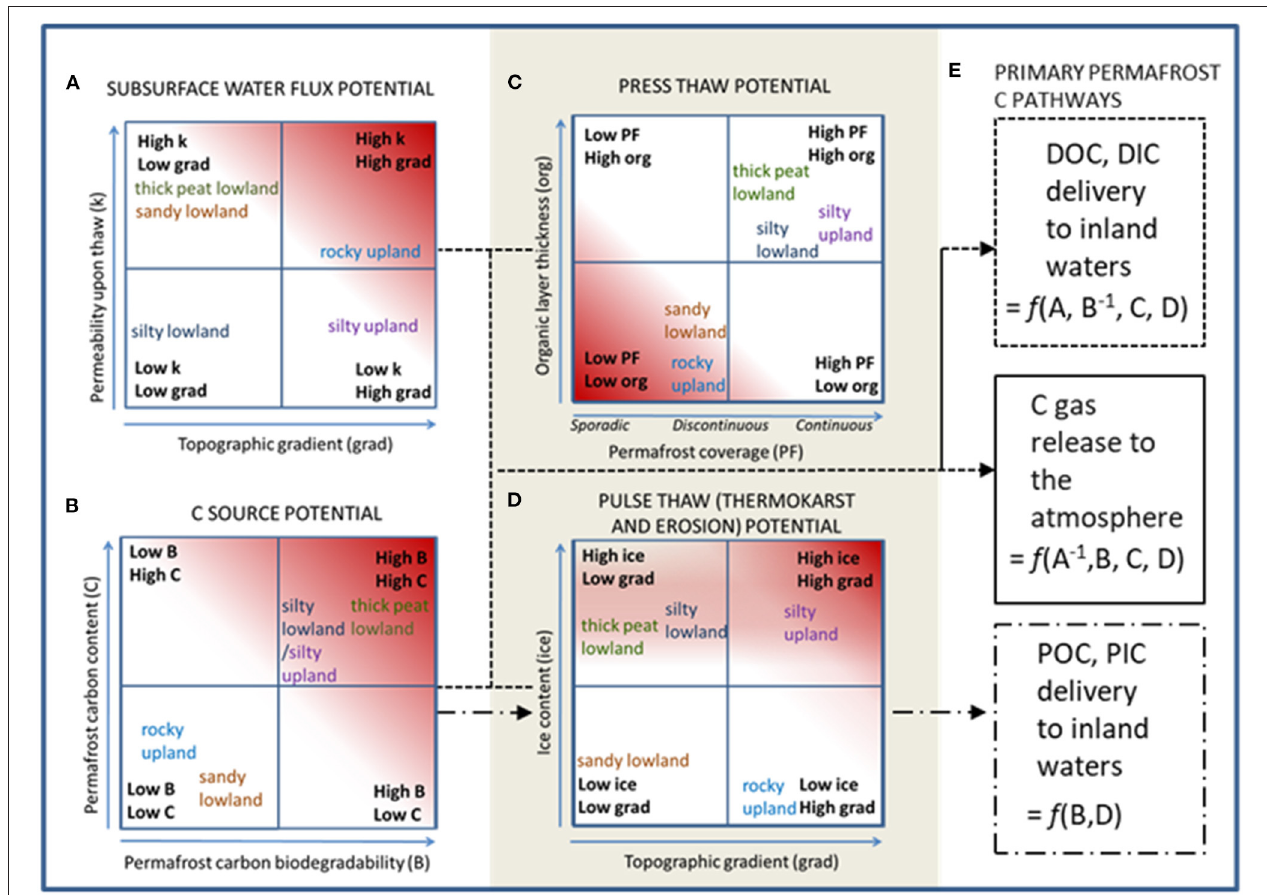
FIGURE 4 | Framework depicting primary characteristics influencing (A) subsurface hydrology (B) permafrost carbon source strength, and (C,D) permafrost thaw, and the collective effect on (E) the fate of permafrost carbon delivered to coastal and inland waters where it is mineralized and/or stored in sediments. Red shading represents conditions with the highest potential for (A) lateral hydrologic flux, (B) carbon source strength, (C) press thaw, and (D) pulse thaw. Representative, generalized hydrogeologic landscapes (thick peat lowland, sandy lowland, silty upland, silty lowland, rocky upland) are noted in colored text and are provided to demonstrate the non-alignment of hydrologic, biogeochemical, and thaw